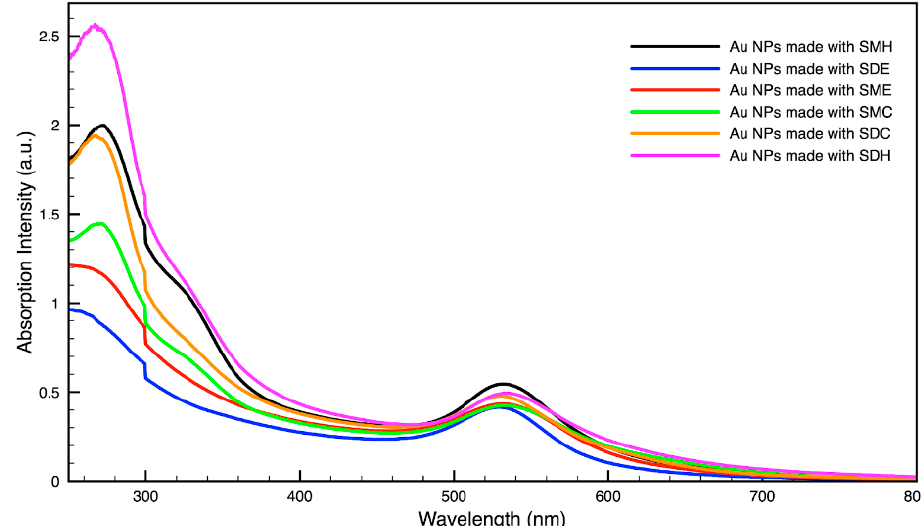
Figure 3. Absorption spectrum of gold (Au) nanoparticles (NPs) synthesized using various forms of spent coffee ground extract.